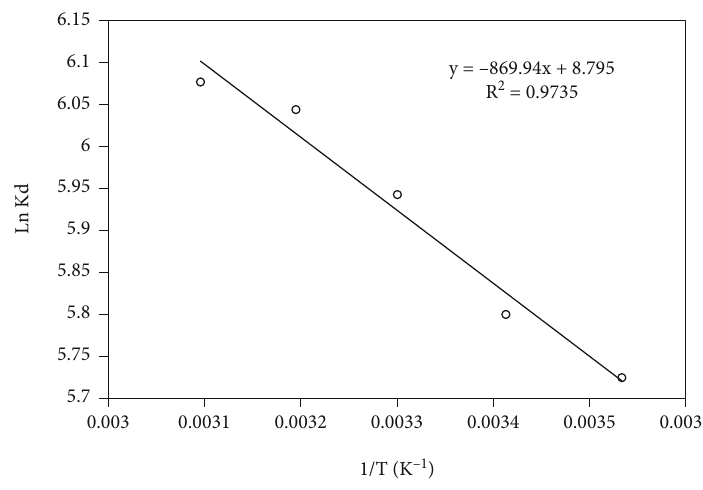
Figure 9: Van ’ t Ho ff plot for carmoisine adsorption on ND. Table 2: Thermodynamic parameter values for carmoisine adsorption equilibrium on ND. T ( ° C) Thermodynamic equilibrium constant (Kd)